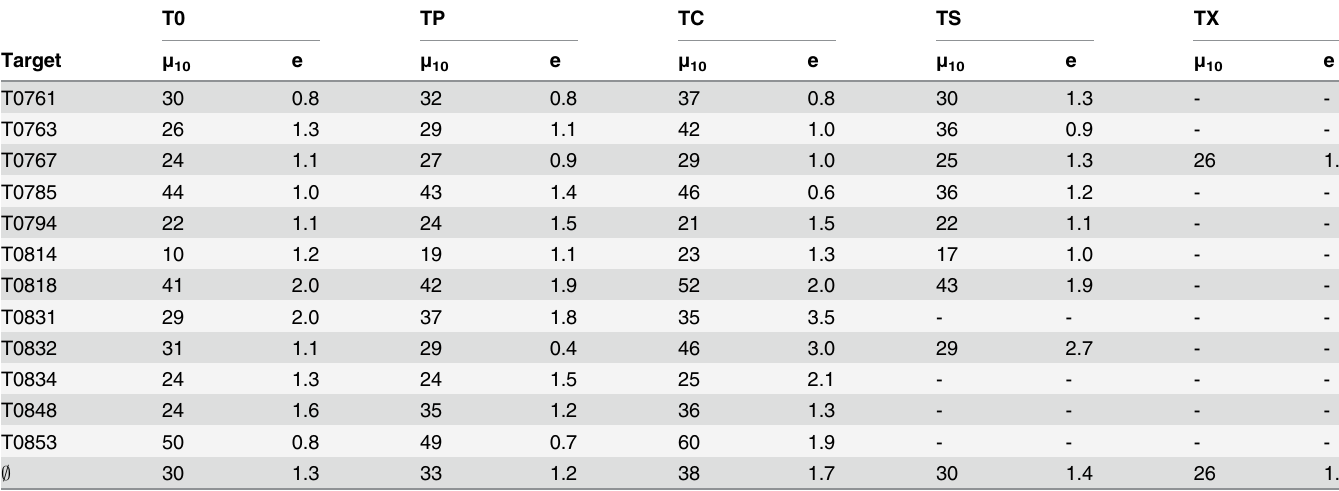
contacts (TP) and only correct residue-residue contacts (TC) were provided for all twelve assis-